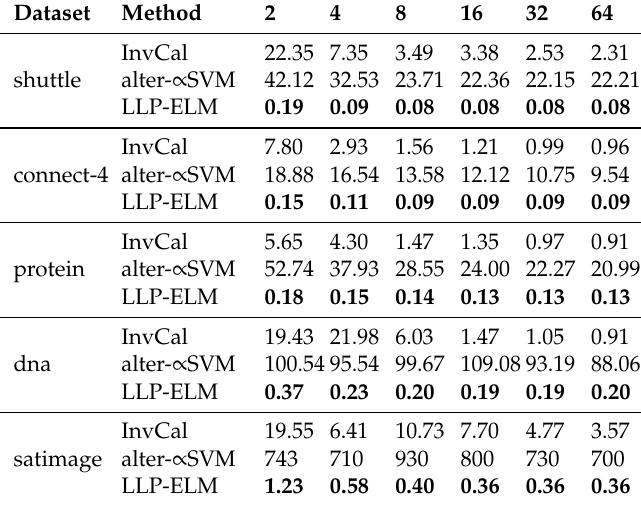
Table 6. Training time (second) of different algorithms with bag size 2, 4, 8, 16, 32 and 64 on multi-class datasets. Bold numbers denote the least training